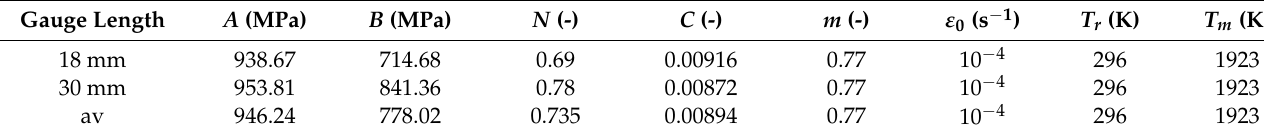
Figure 7. Normalized yield strength characteristic at strain value ε = 0.02 for specimen gauge length: 18 mm ( a ) and 30 mm ( b ).